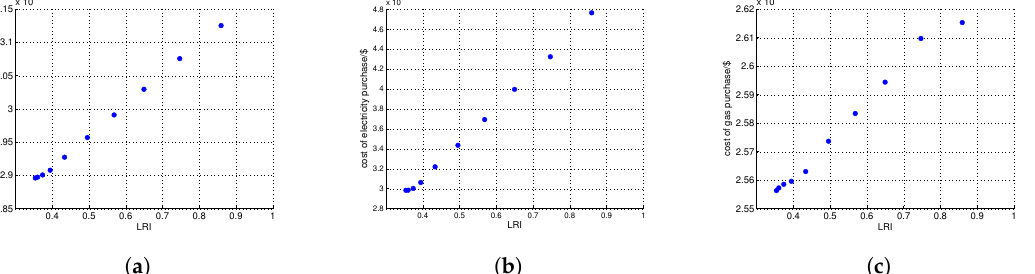
0.4 0.5 0.6 0.7 0.8 0.9